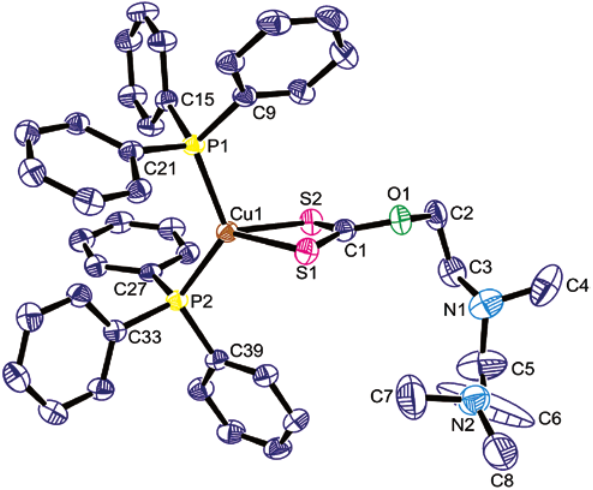
Figure 5: The asymmetric unit of 5 showing the labelling scheme used; thermal ellipsoids are at the 50% probability level. Only the major component of the disordered NCH CH NMe unit is shown. 2 2 2 Two molecules of CH Cl also present in the lattice have been 2 2 omitted for clarity. Only the α -carbons attached to phosphorus have been labelled for clarity, the remaining carbon atoms being numbered sequentially around each ring. Selected geometric